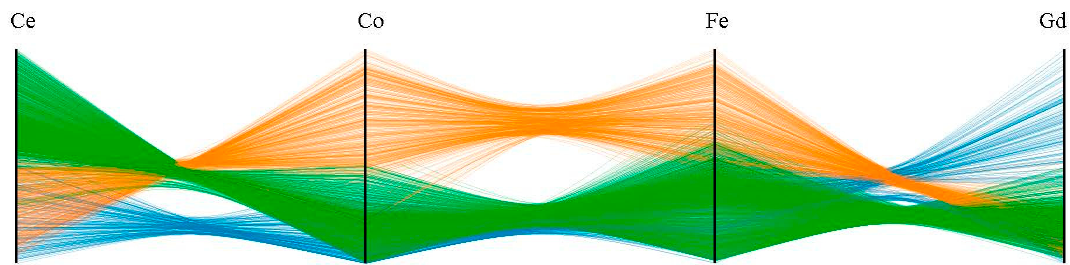
Figure 3. The battery dataset visualized with parallel coordinates